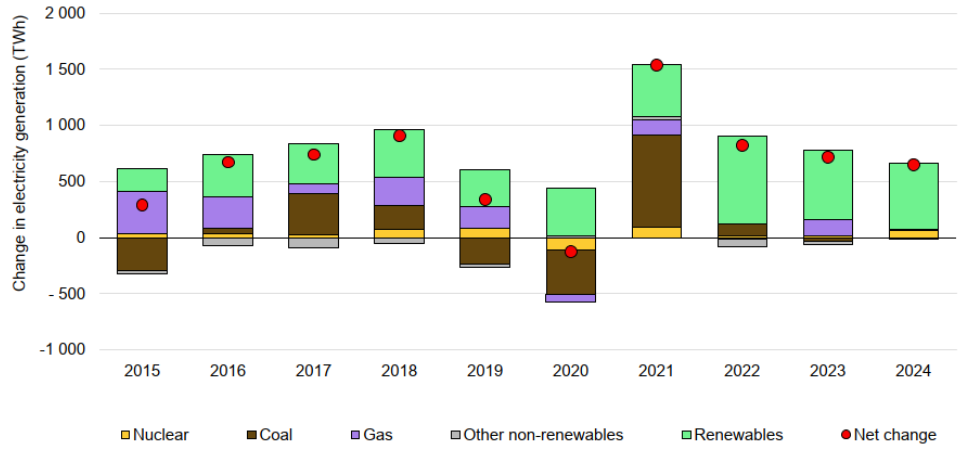
Figure 3. Global change in electricity generation 2015 – 2024. Source: IEA.